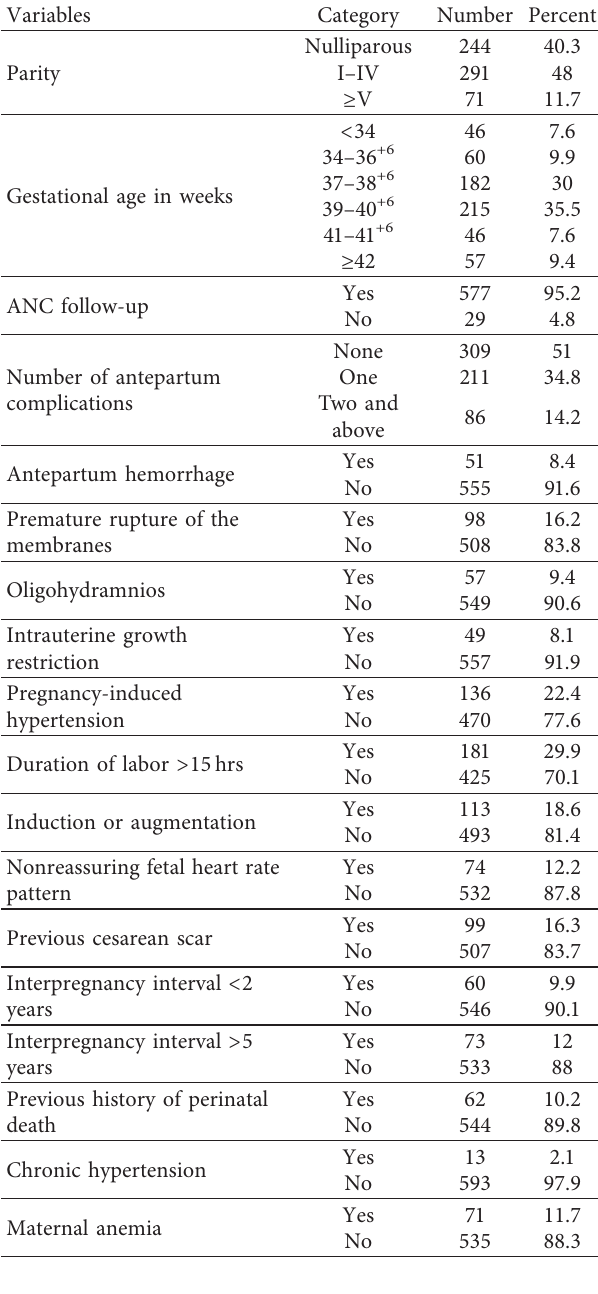
Table 3: Description of labor and delivery outcome variables of study participants in Felege Hiwot Referral Hospital, June–August 2018 ( n �